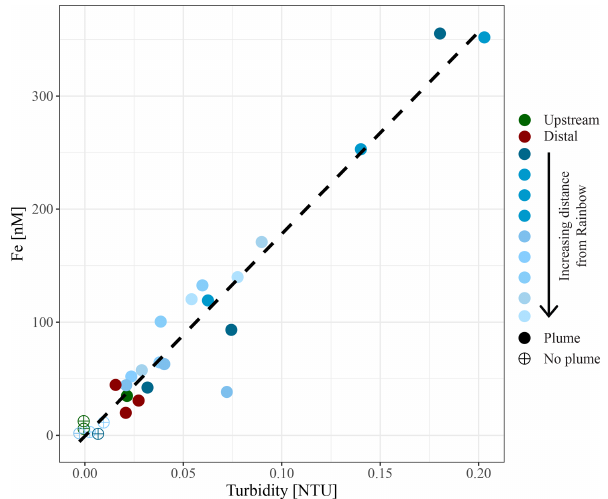
Figure 5. Relationship between in situ measured turbidity and mo- lar concentration of particulate